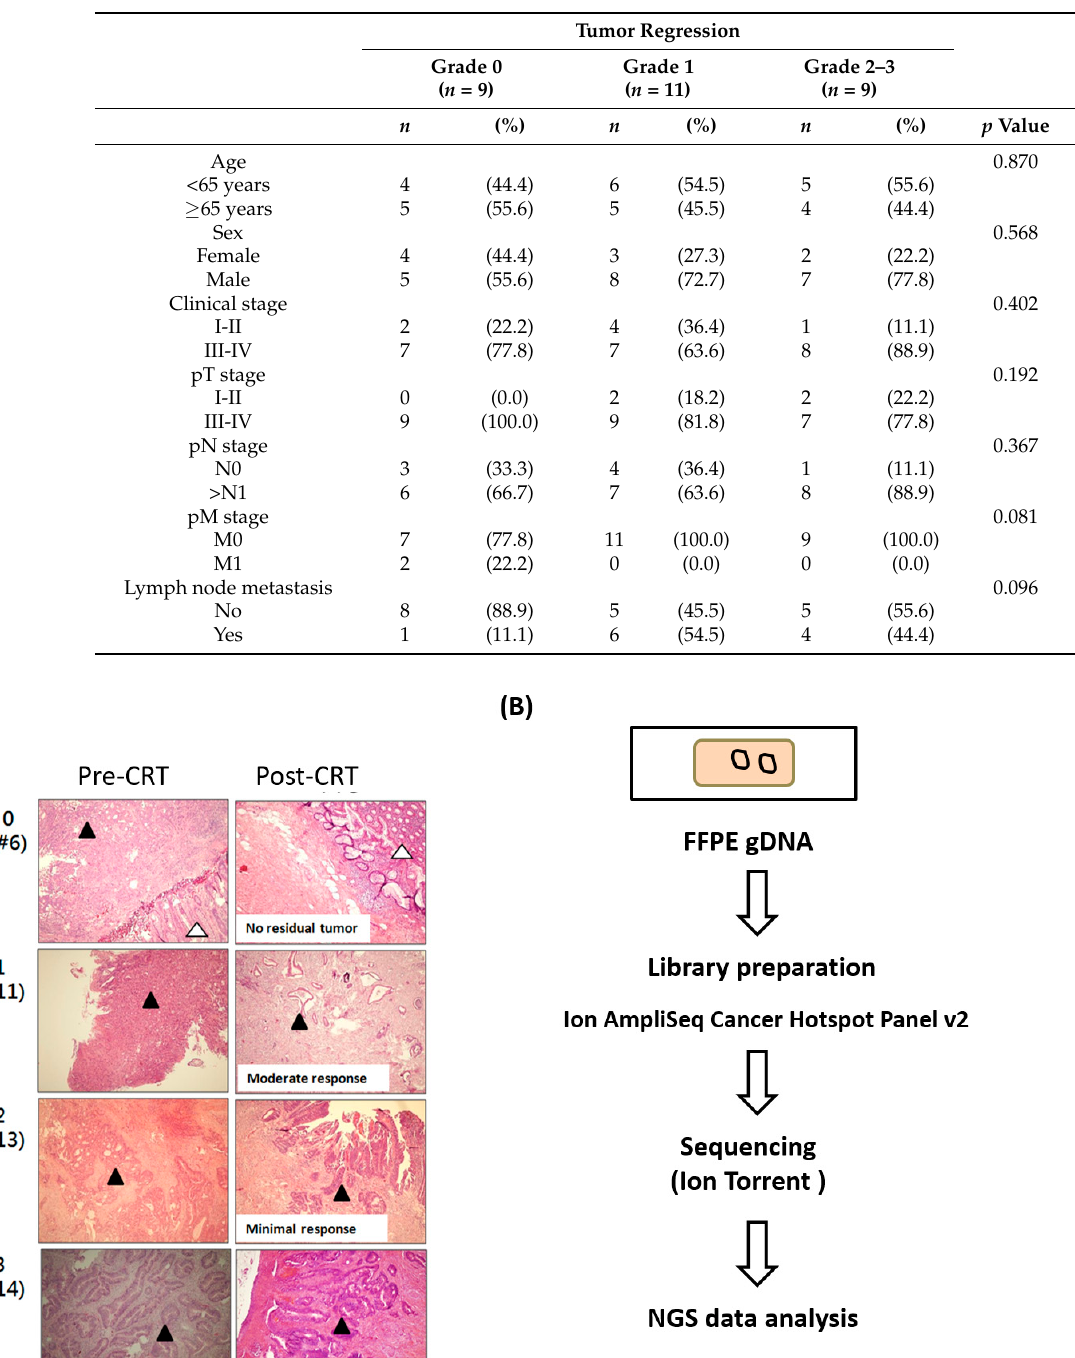
Table 1. Clinicopathological characteristics of 29 patients with rectal carcinoma.